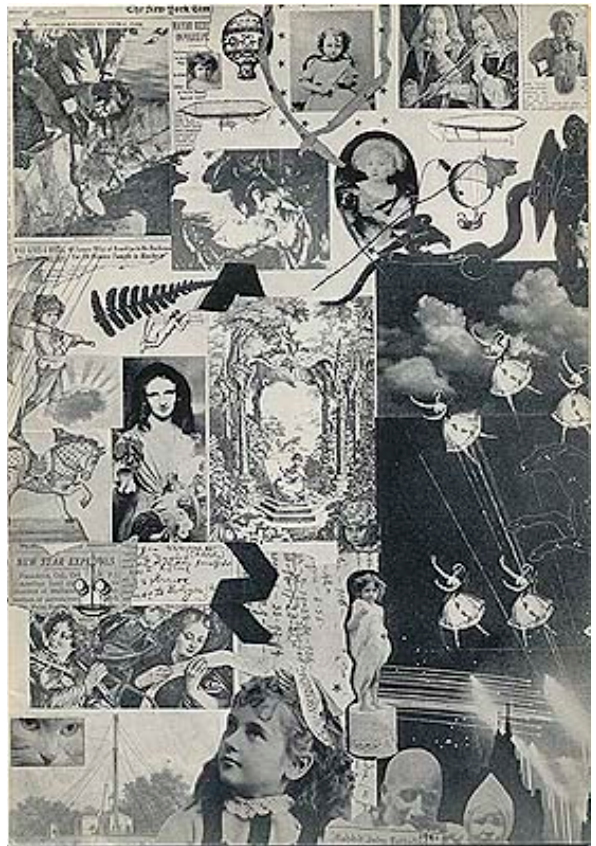
Figure 6. Joseph Cornell, Collage, The Crystal Cage (Portrait of Berenice) , View , January 1943. © The Joseph and Robert Cornell Memorial Foundation/Licensed by VAGA at Artists Rights Society (ARS), NY. Used with permission.